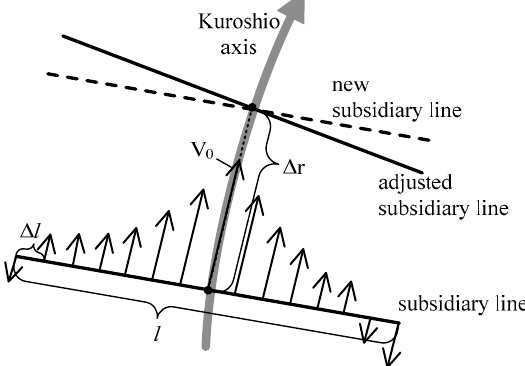
Figure 2. Schematic diagram showing the method how to detect the Kuroshio axis by tracking the maximum speed of the surface velocity. V 0 denote the local maximum velocity, ∆ r is the distance between two adjacent subsidiary line (before the new subsidiary line being adjusted), l is the length of the subsidiary line, ∆ l is the interval between two adjacent points.